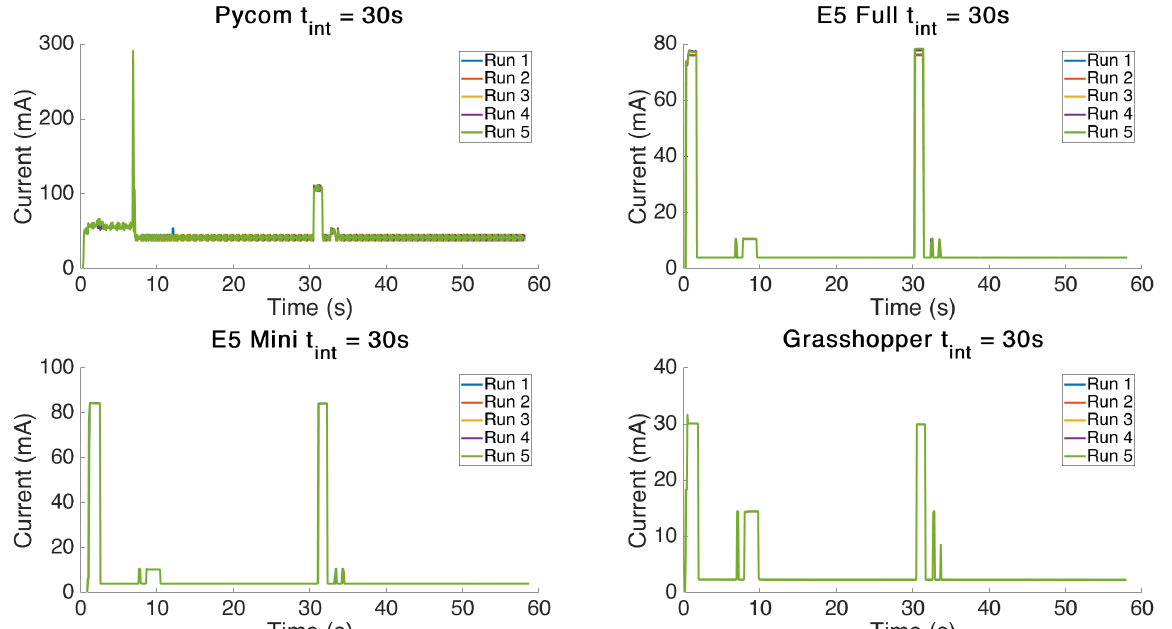
Figure 2. Multiple board power variability over multiple